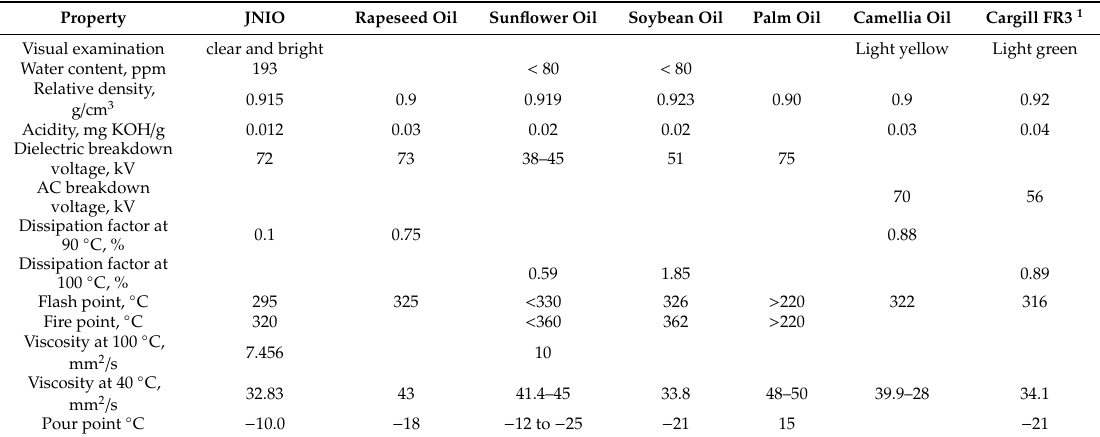
Table 3. Statistics of types and performance for vegetable insulation